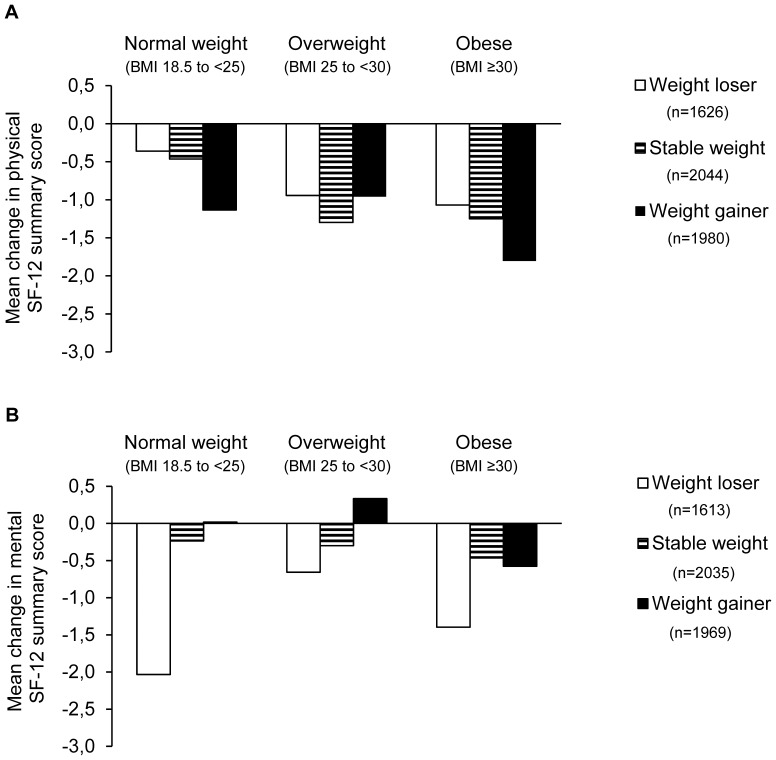
Mean changes in the physical (part A) and mental (part B) SF-12 summary scores from baseline to 36-month follow-up according to baseline BMI category in three weight-change groups.Weight-change groups: weight loser (BMI change over 36 months <−0.5 kg/m2), stable weight (BMI change −0.5 to 0.5 kg/m2), and weight gainer (BMI change >0.5 kg/m2). Abbreviations: BMI = body mass index in kg/m2, SF = Short Form.